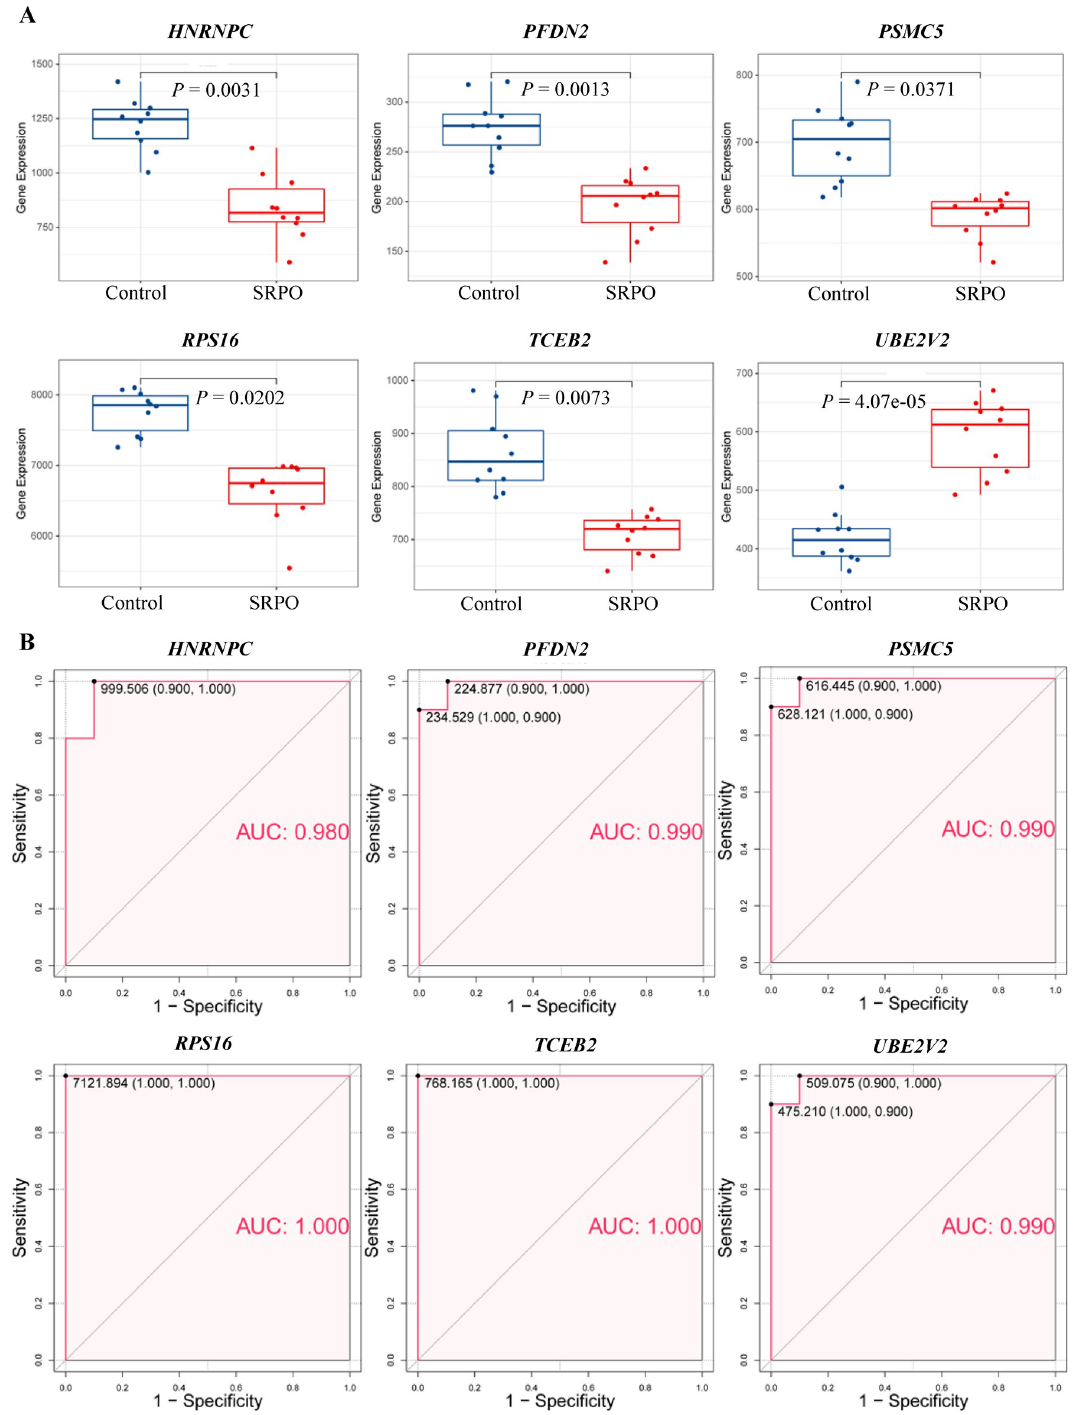
Fig 7. Diagnostic efficiency evaluation of feature genes. (A) Gene expression of six feature genes ( HNRNPC , PFDN2 , PSMC5 , RPS16 , TCEB2 , and UBE2V2 ) in women with smoking-related postmenopausal osteoporosis and controls. (B) Receiver operating characteristic curve analysis.